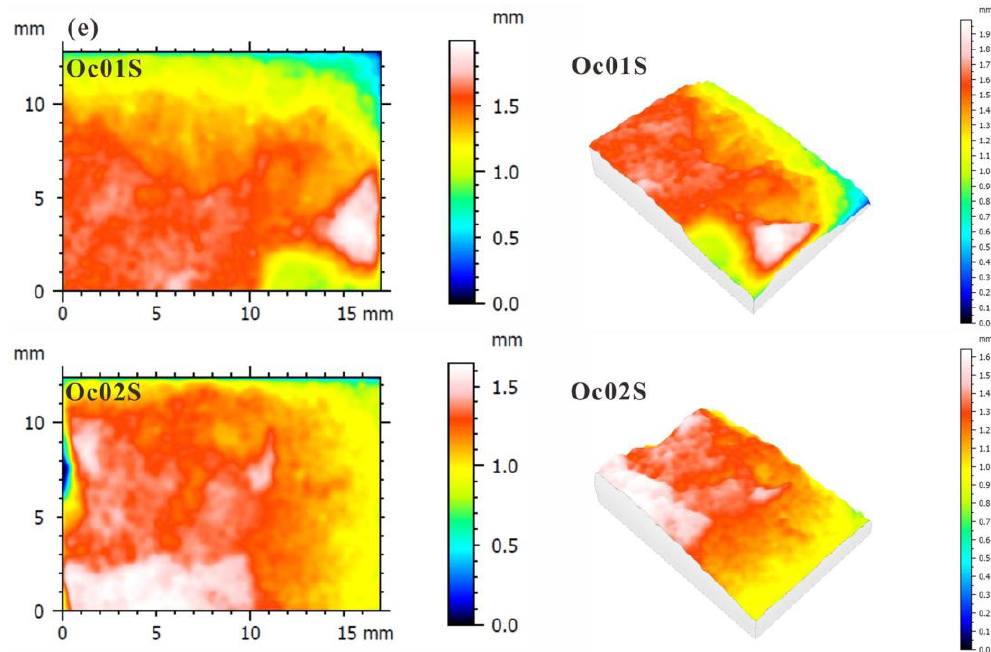
Figure 11. Representative 2D and 3D fracture surface roughness after the angle-varied plate shear test. The sample number is given at the top-left of each image. ( a – e ) corresponds to the shale laminae of Cal, Py, Cal-Oc, Py-Oc, and Oc respectively.